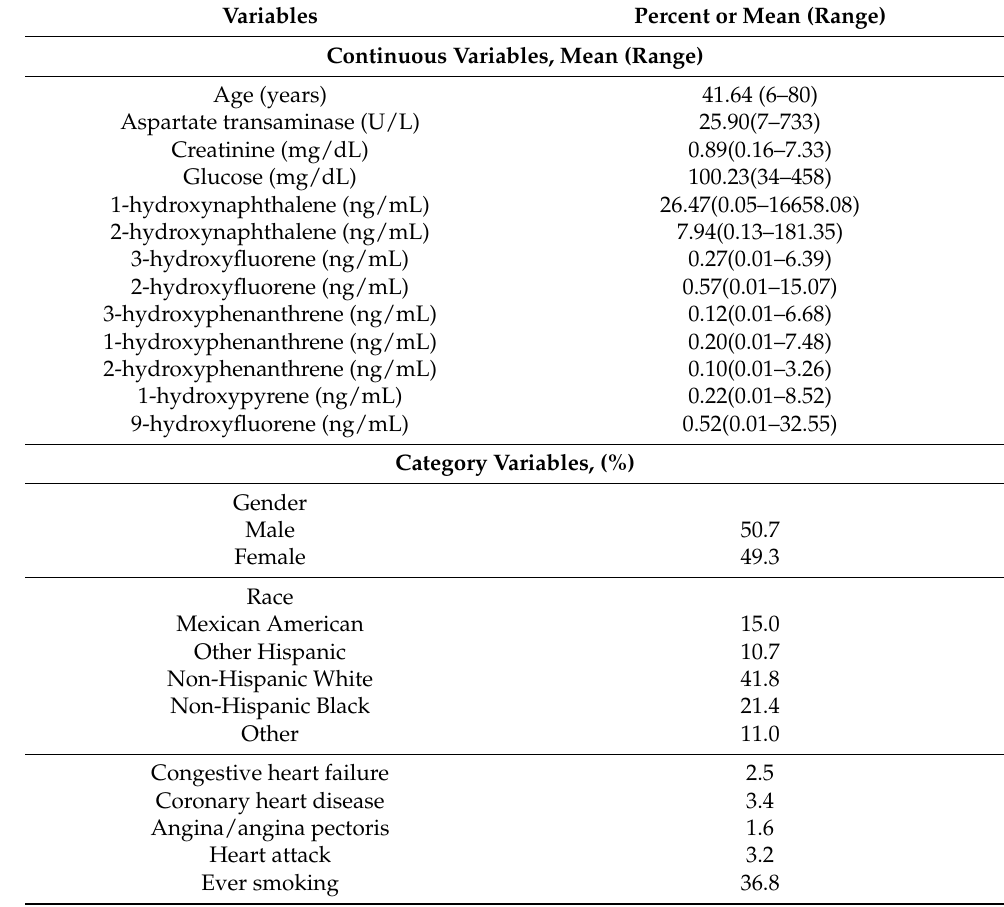
Table 1. Characteristics of the study population ( n =